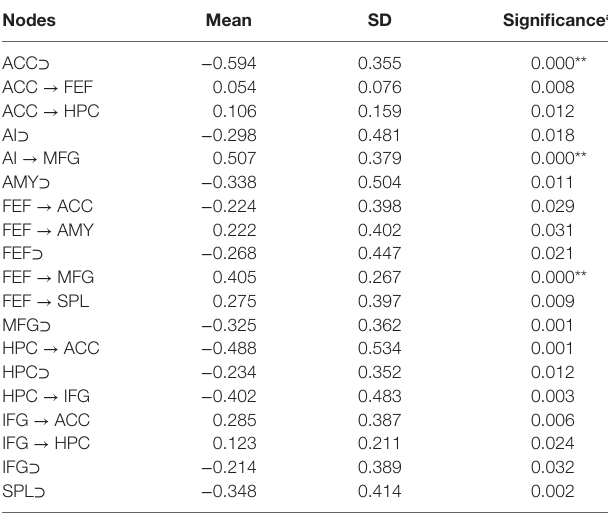
Table 2 | Connections significantly different from 0 in healthy